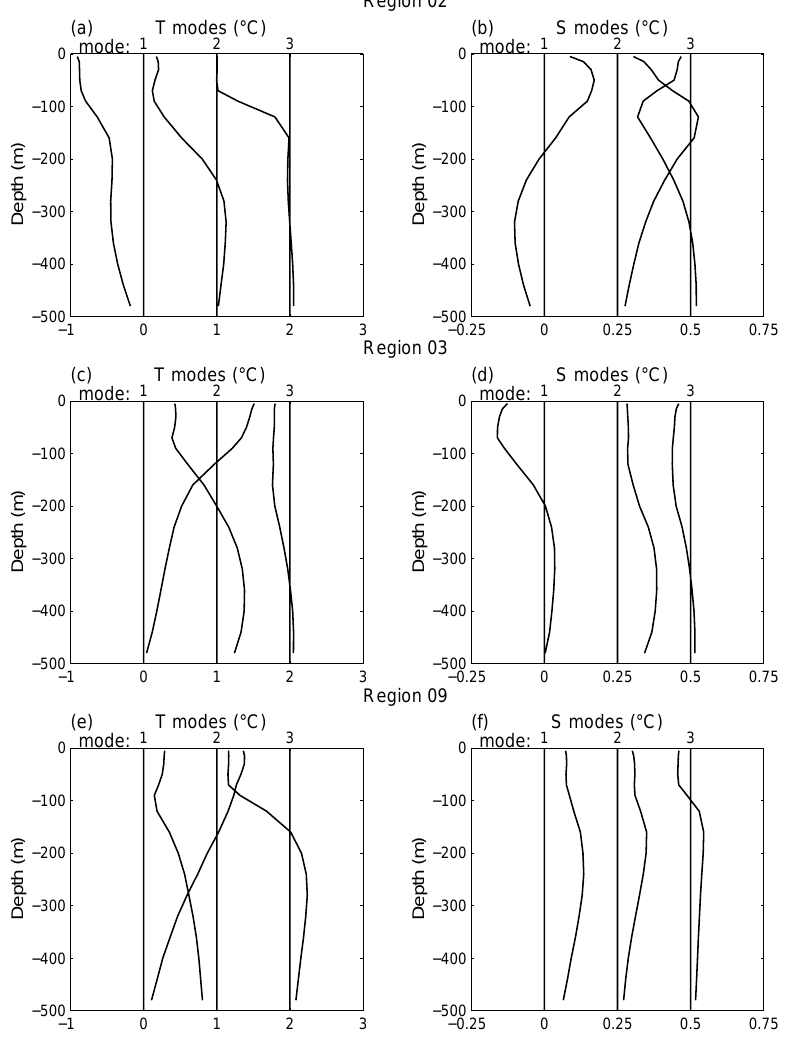
Fig. 9. Winter EOFs from model data. Temperature (a) and salinity (b) for the Algerian Basin, temperature (c) and salinity (d) for the northwestern Basin, and temperature (e) and salinity (f) in the Levantine Basin. The first three modes are